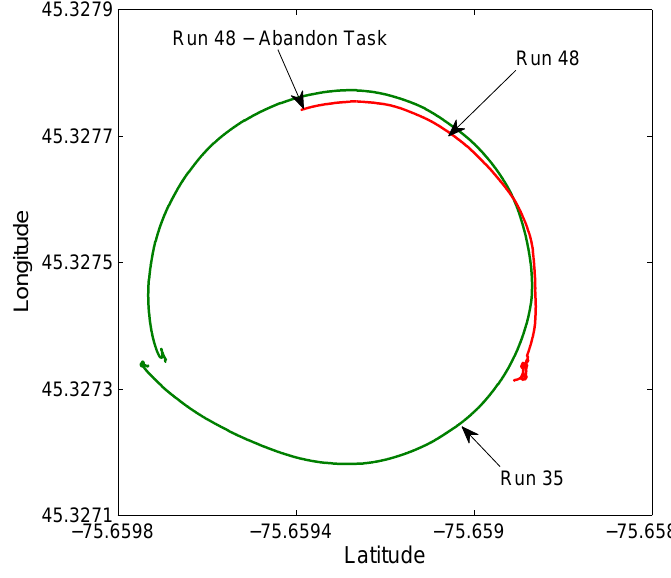
Figure 12. Comparison ground position during the completion of the Pirouette